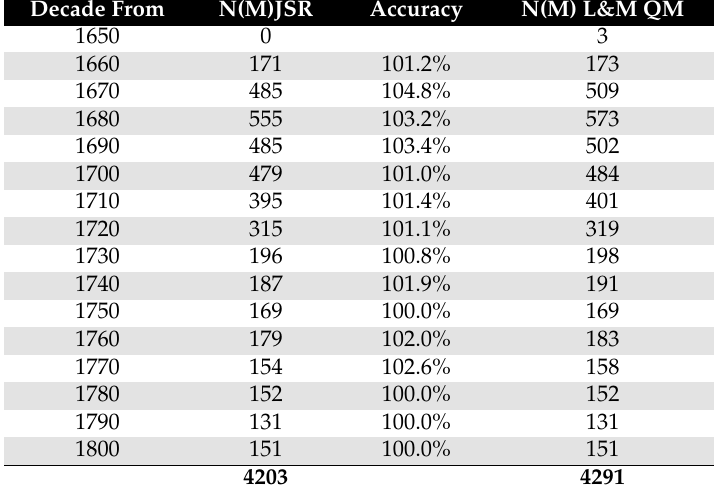
Table 1. Comparison of Rowntree’s marriages by decade with the London and Middlesex Quarterly Meet (L&M QM) marriage registers.